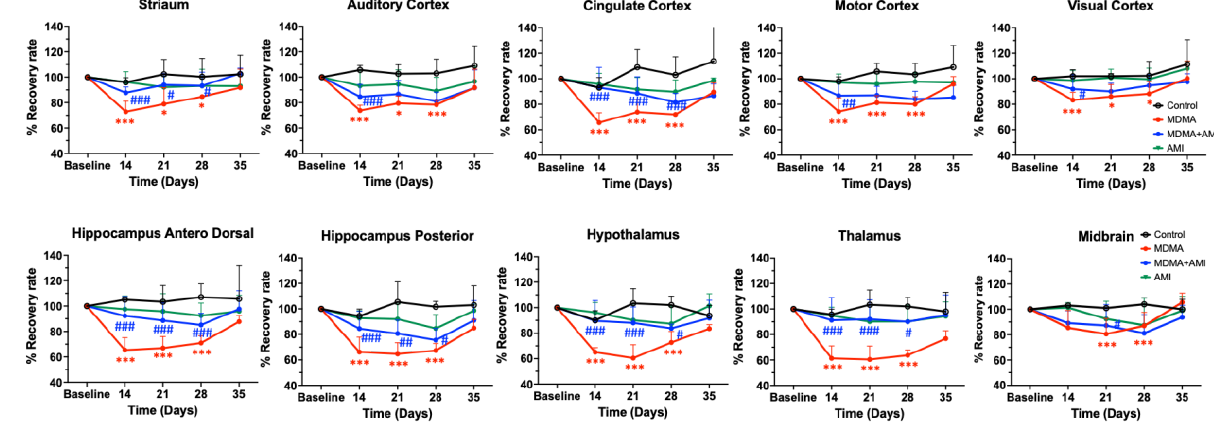
Figure 5. Comparison of recovery rate, based on graphical analyses of 4-[ 18 F]-ADAM binding before and after drug administration. Among four groups, the MDMA group (red line) showed the lowest recovery rate at day 14, slightly increased at day 21, and recovered to ~70% of baseline value at day 35 (red line and red * p < 0.05, *** p < 0.005, Group B-MDMA vs. Group A-control). MDMA with AMI pre-treatment significantly accelerated the recovery rate from day 14 and slowly increased up to day 35 when compared with the MDMA group (blue line and blue # p < 0.05, ## p < 0.01, ### p < 0.005, Group C-MDMA+AMI vs. Group B-MDMA). The control and AMI alone (green line) groups showed similar pattern in recovery rate. Data are mean ± SD. Detailed statistical results between each group are summarized in Figure